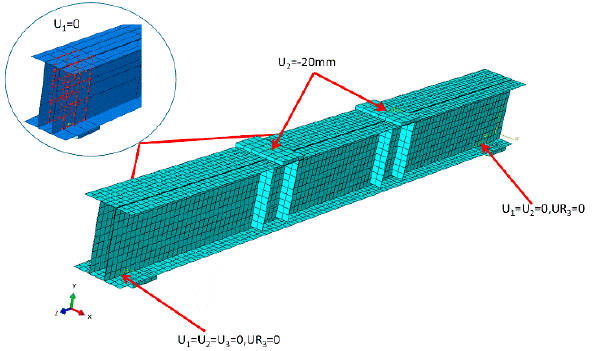
Figure 10. FE model of K4 beam.